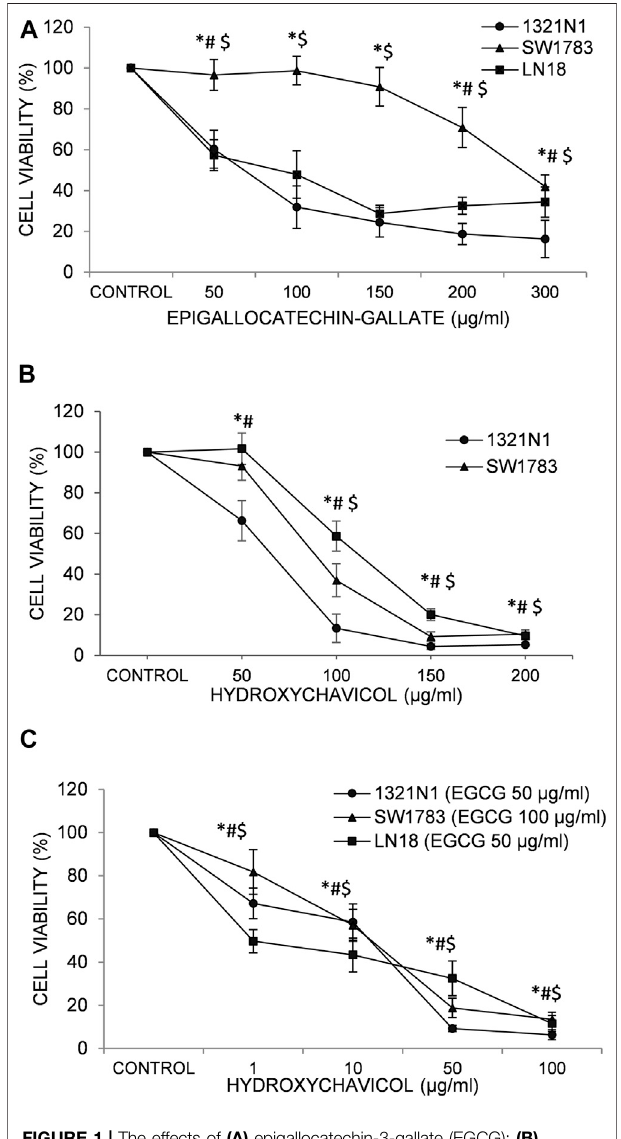
FIGURE 1 | The effects of (A) epigallocatechin-3-gallate (EGCG); (B) hydroxychavicol (HC); and (C) EGCG+HC on 1321N1, SW1783, and LN18 after 24-h. The data re fl ects the mean±SD of three independent experiments. * p < 0.05 compare to 1321N1vehicle control, # p < 0.05 compare to SW1783 vehicle control, and $ p < 0.05 compare to LN18 vehicle